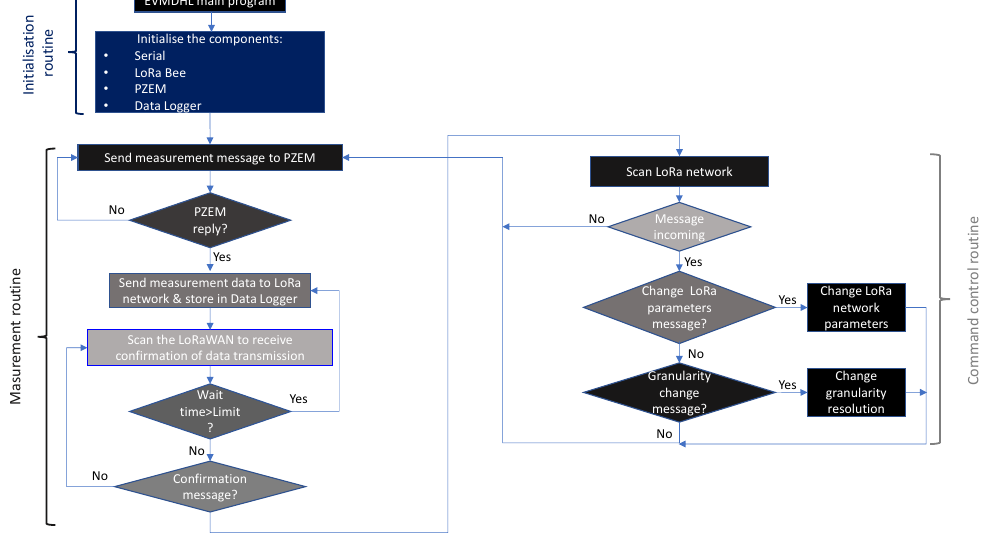
Figure 9. Flowchart of the main program for the EVMDHL. The effective voltage is defined by the square root of the mean value. Equation (1) allows the calculation of the RMS voltage, where V RMS represents the value of the effective voltage, N is the number of samples and v j is the j th measurement of the voltage signal.